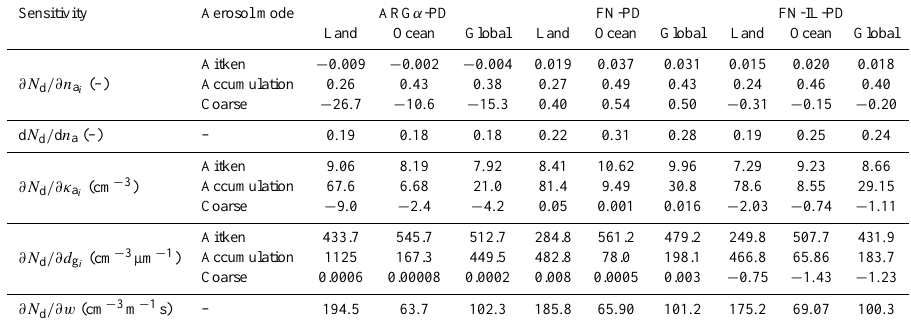
Table 4. Annual mean sensitivities computed for the PD simulations. Fields are reported for the 930mb pressure level. Sensitivity Aerosol